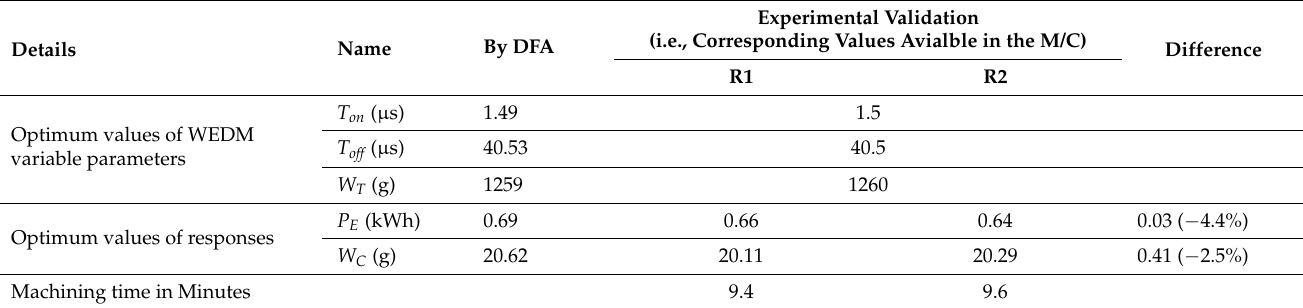
Table 3. Desirability function analysis-based predictions for optimization and results of confirmation